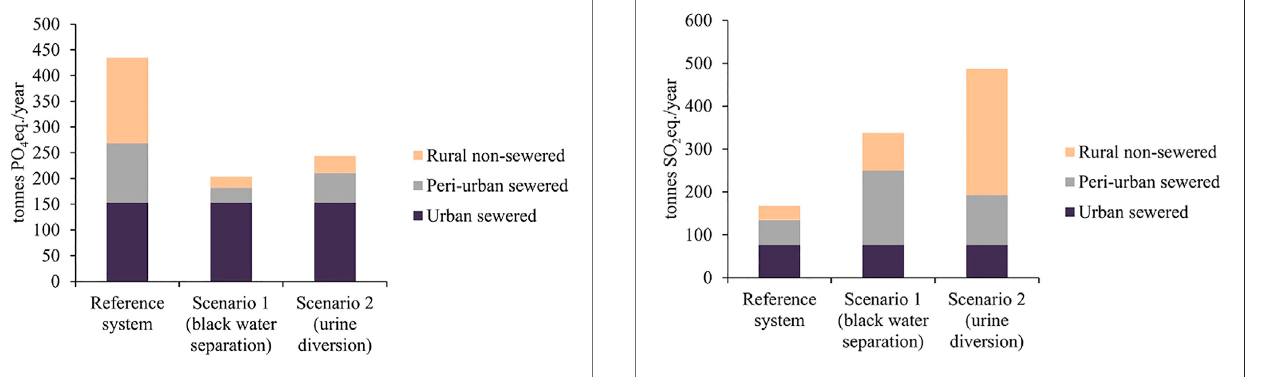
FIGURE 4 | Eutrophication (tonnes PO 4 eq./year) impacts of Reference System and de fi ned source separation Scenarios 1 and 2 as well as the contribution of urban, rural and peri-urban